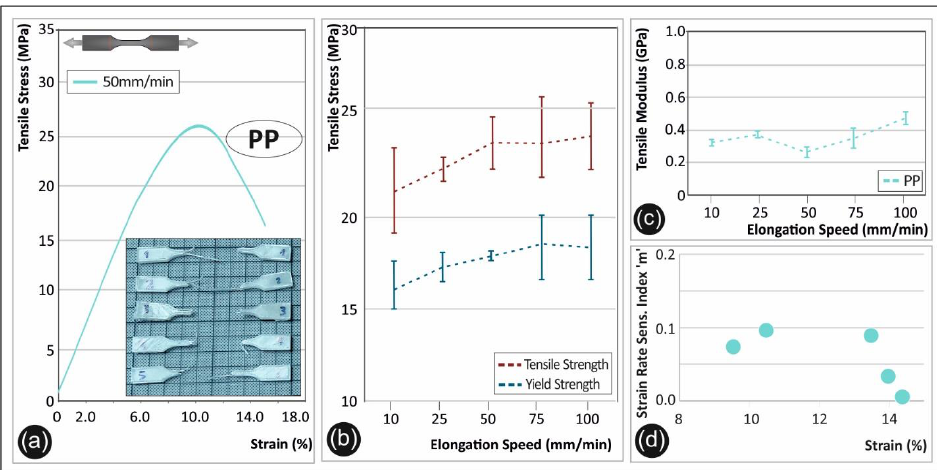
Figure 6. ( a ) Representative tensile stress (MPa)—strain (%) curve of polypropylene (PP) at a 50 mm/min elongation speed, ( b ) average tensile strength and yield strength (with the corresponding standard deviation) for PP in all five elongation speeds, ( c ) tensile modulus (with the corresponding standard deviation) of PP under the five different elongation speeds, and ( d ) strain rate sensitivity index “m”—strain (%) graph for PP.